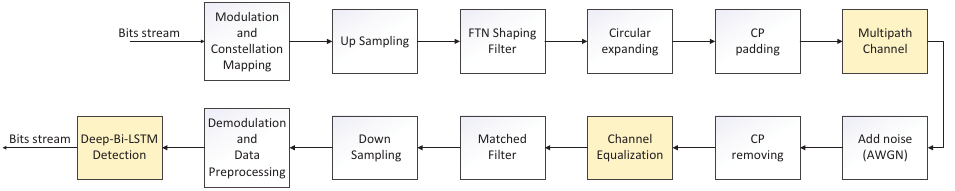
Figure 1. Block diagram of the transmission model of FTN signal detection communication system based on the DMD-JD